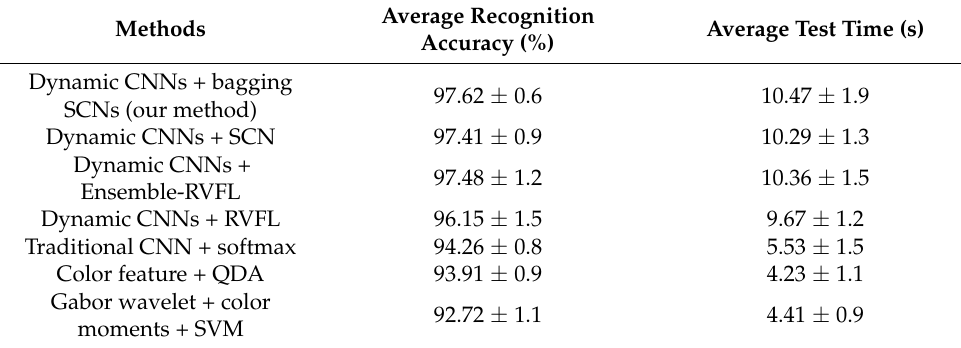
Table 1. Comparison of various methods.